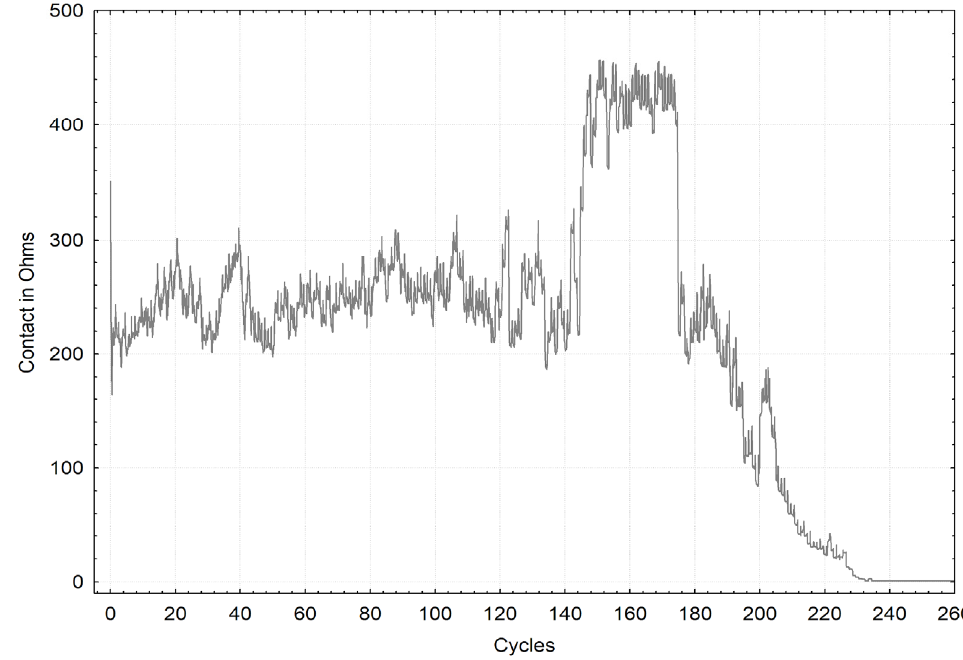
Figure 7. Selected graph of the durability of the “white” S220GD coating.